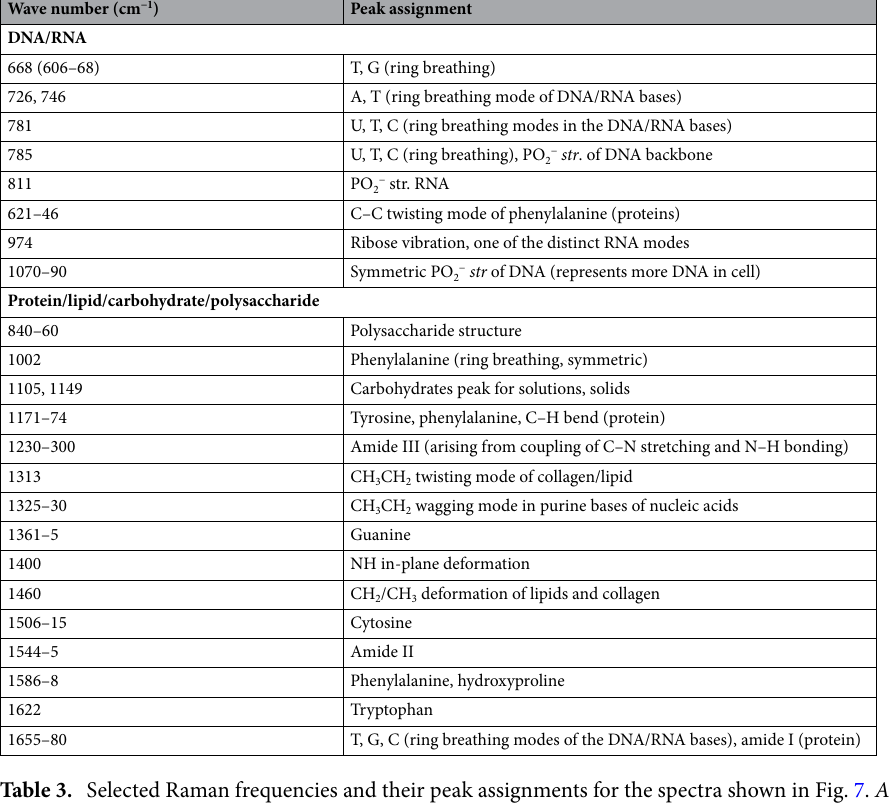
Table 3. Selected Raman frequencies and their peak assignments for the spectra shown in Fig. 7. A adenine, C cytosine, G guanine, PO 2 − phosphate, str stretching, T thymine, U uracil. Assignments are based on studies in the references.